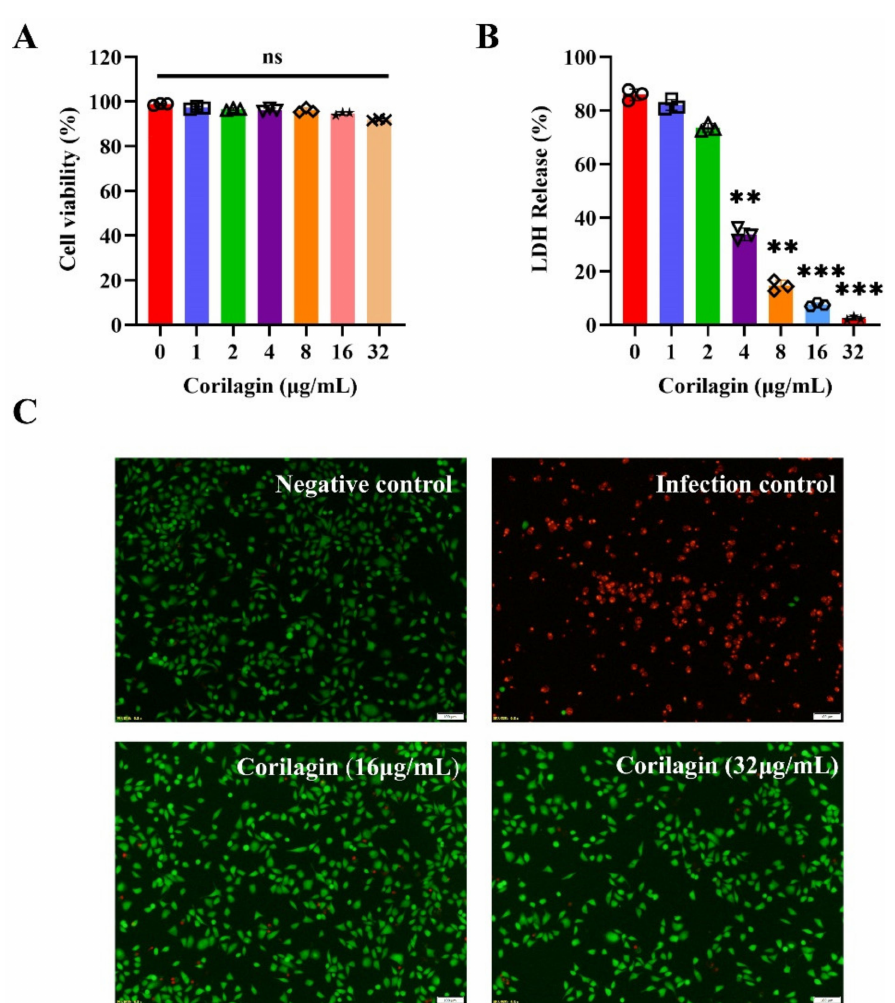
Figure 3. Corilagin relieved PLY-mediated A549 cell damage. ( A ) The cell viability of A549 cells after being treated by corilagin at different concentrations (0, 1, 2, 4, 8, 16 and 32 µ g/mL). (ns, no significant difference). ( B ) The LDH release detection of A549 cells incubated with purified PLY with various concentrations of corilagin treatment (0, 1, 2, 4, 8, 16 and 32 µ g/mL). ** p < 0.01, *** p < 0.001. ( C ) The fluorescence images of A549 cells treated with PLY as infection control, corilagin at 16 and 32 µ g/mL, respectively, and no treatment as negative